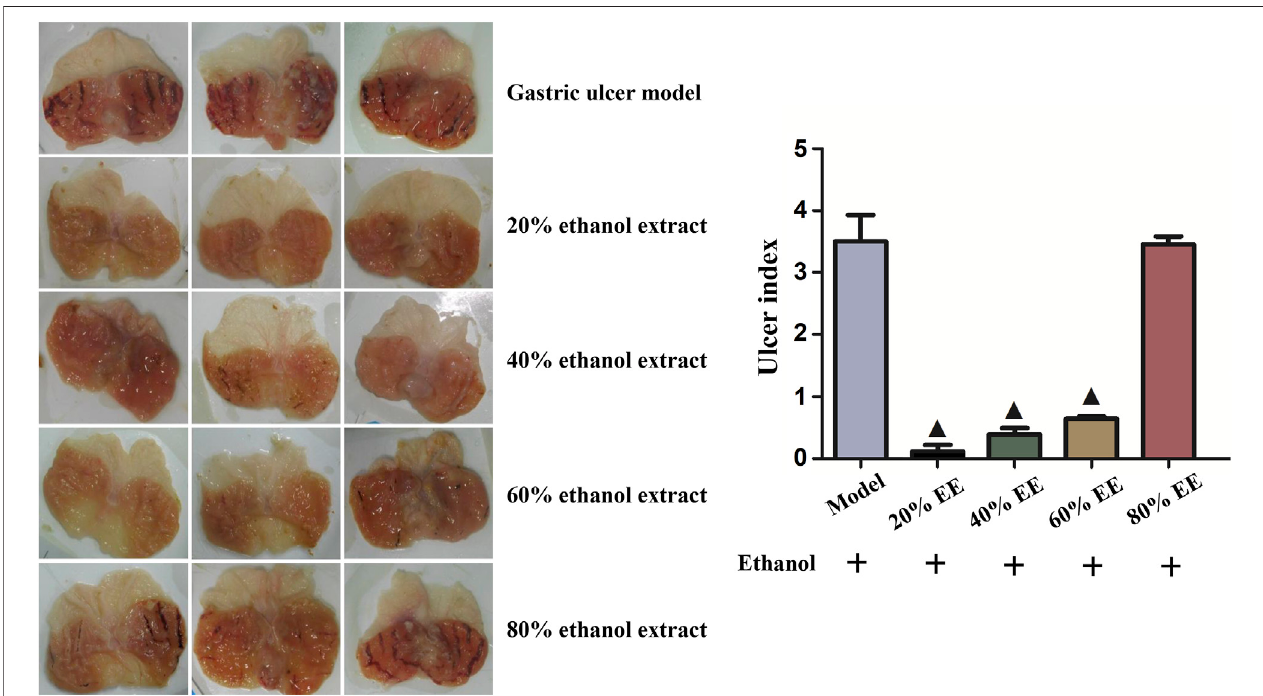
FIGURE 1 | Effects of PAE extracted by a series of concentration of ethanol on the gross appearance of the gastric mucosa and ulcer index in ethanol-induced gastric ulcer in rats. ▲ p < 0.05, PAE treatment group vs. ethanol-induced group.